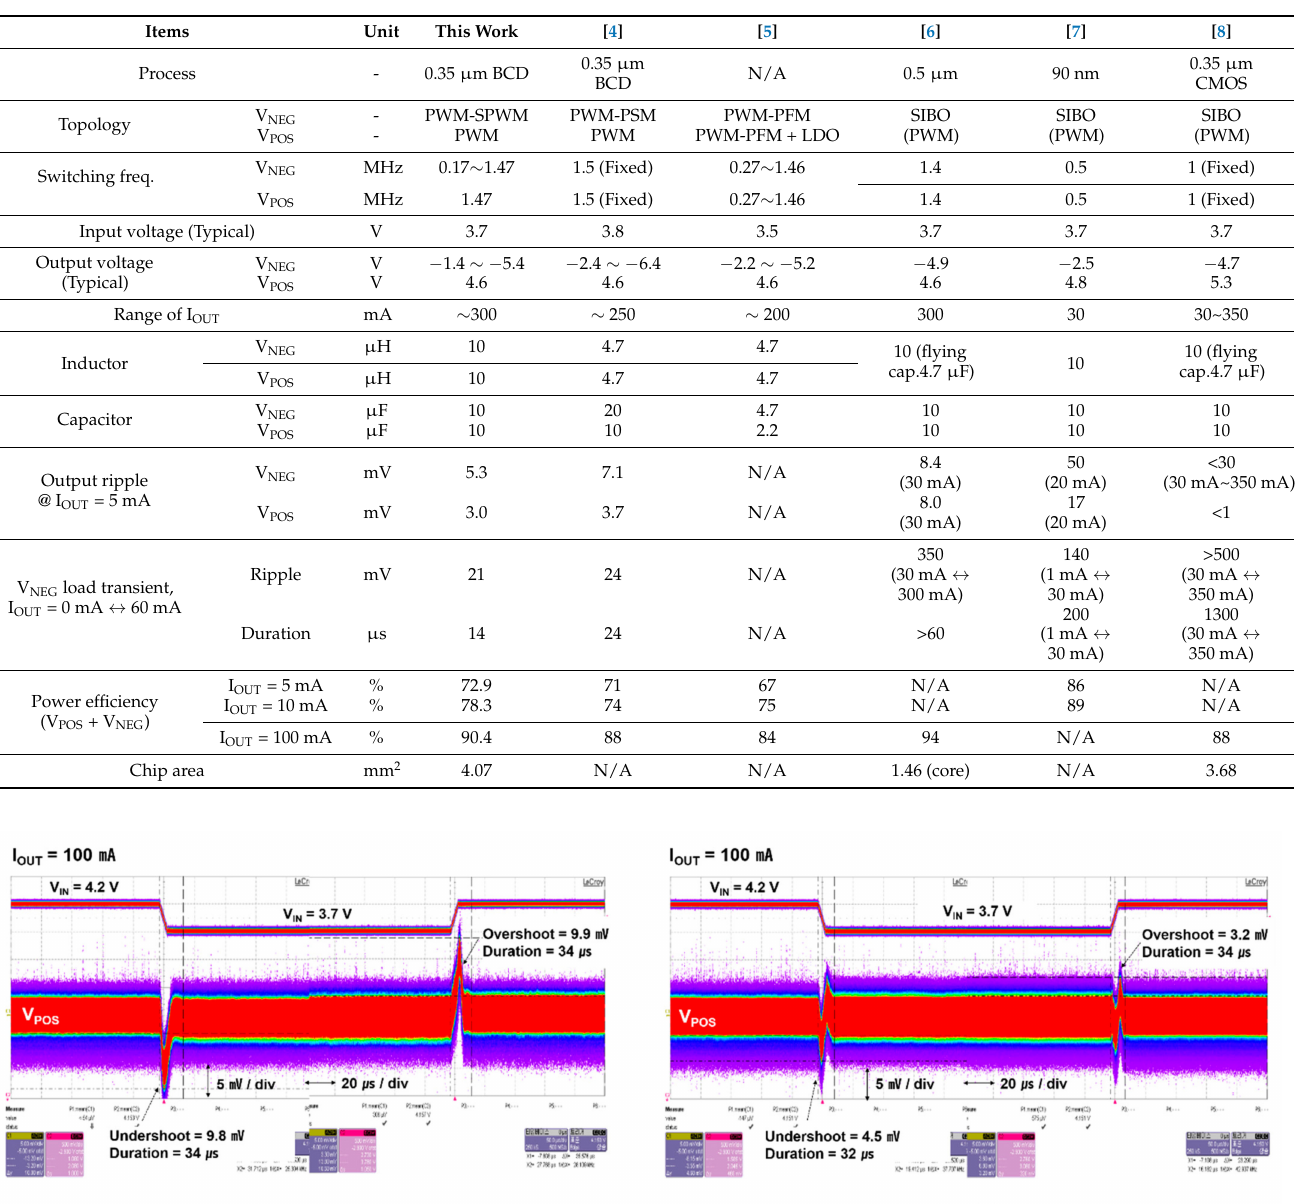
Table 1. Performance of two-channel DC-DC converters for AMOLED displays.